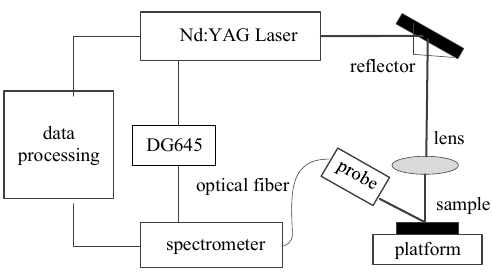
Figure 1. Laser-induced breakdown spectroscopy (LIBS) experimental setup.